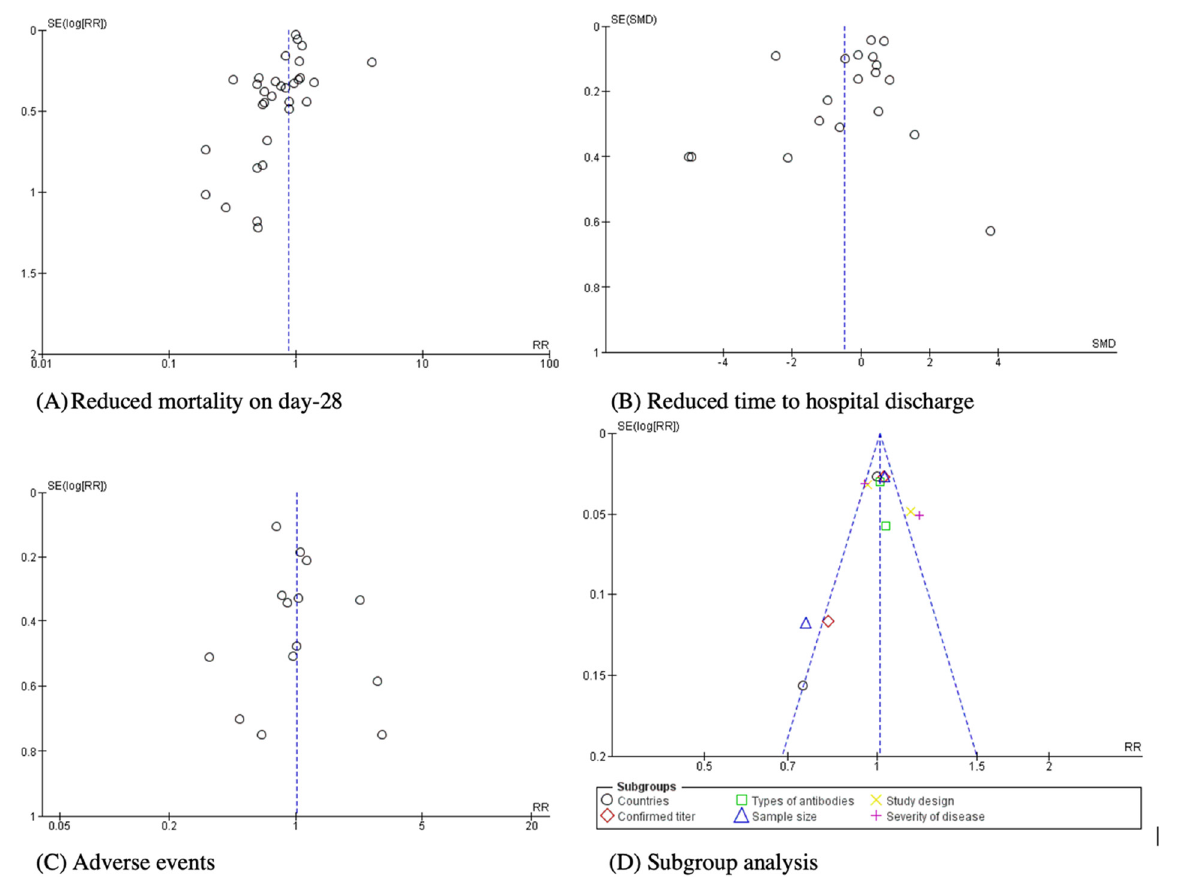
Figure 6. Funnel plots of included RCTs for investigating efficacy of CP transfusion against COVID-19, compared with SOC or placebo treatment.